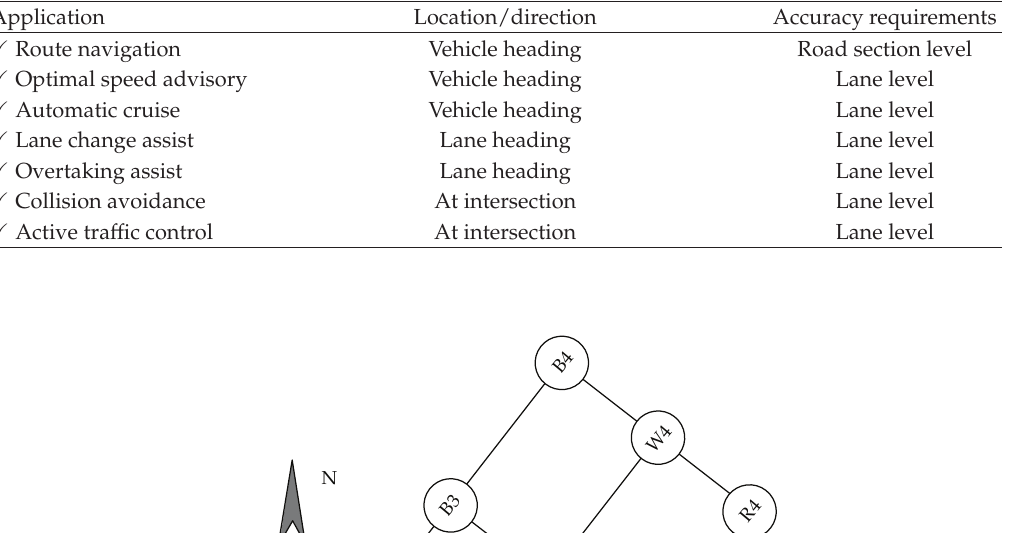
Table 1: Typical CVIS applications and positioning accuracy requirements.